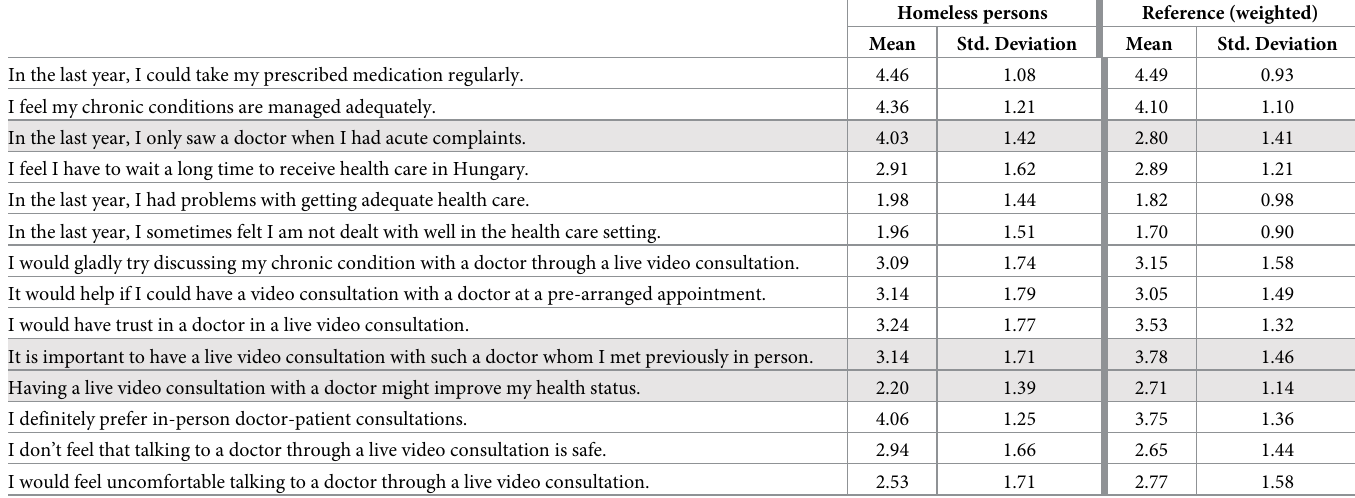
Table 3. Means of attitude responses by the homeless persons and the reference